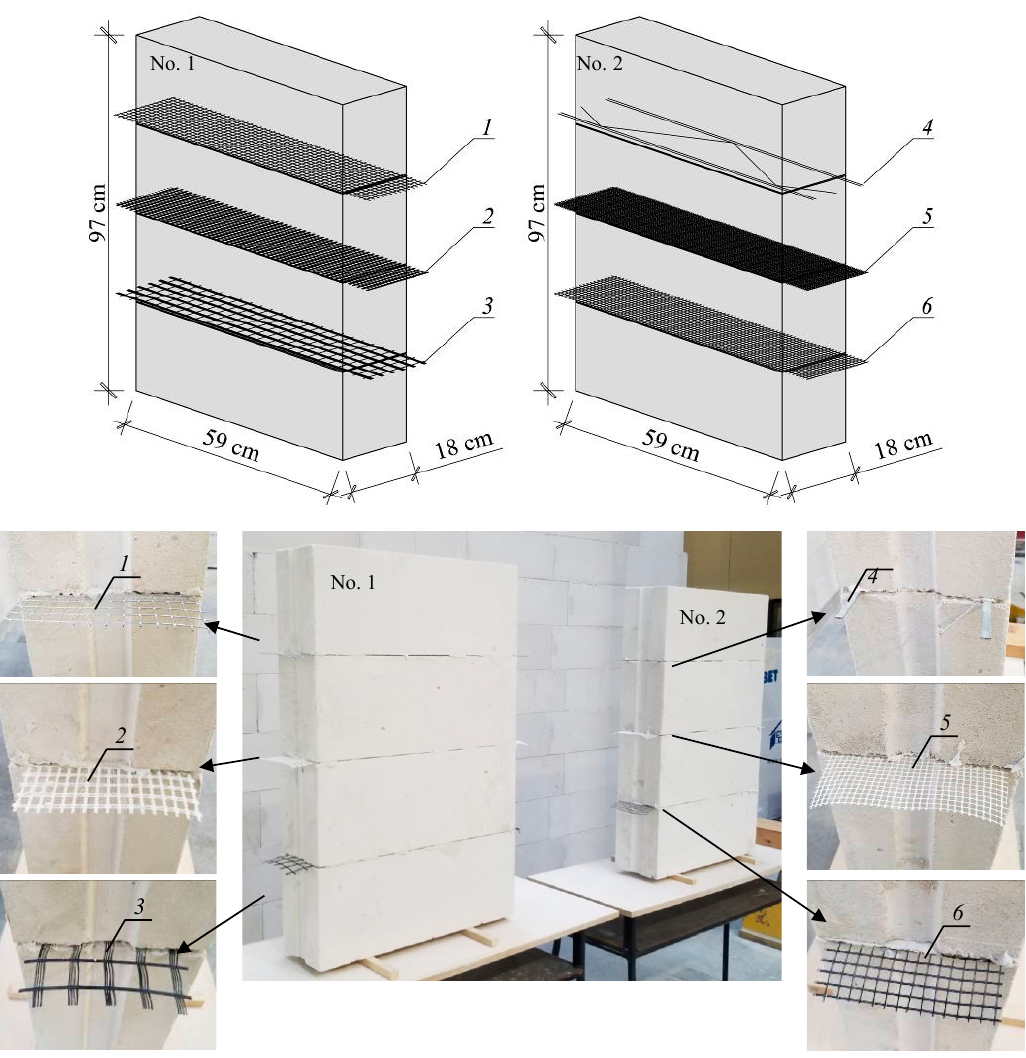
Figure 1. Masonry specimens used in tests: 1—steel mesh reinforcement (size 12 × 12 mm), 2—fibreglass mesh reinforcement (size 10 × 12 mm), 3—basalt mesh reinforcement (size 30 × 30 mm), 4—truss-type reinforcement, 5—fibreglass mesh reinforcement (size 5 × 5 mm), 6—basalt mesh reinforcement (size 8 × 8 mm).